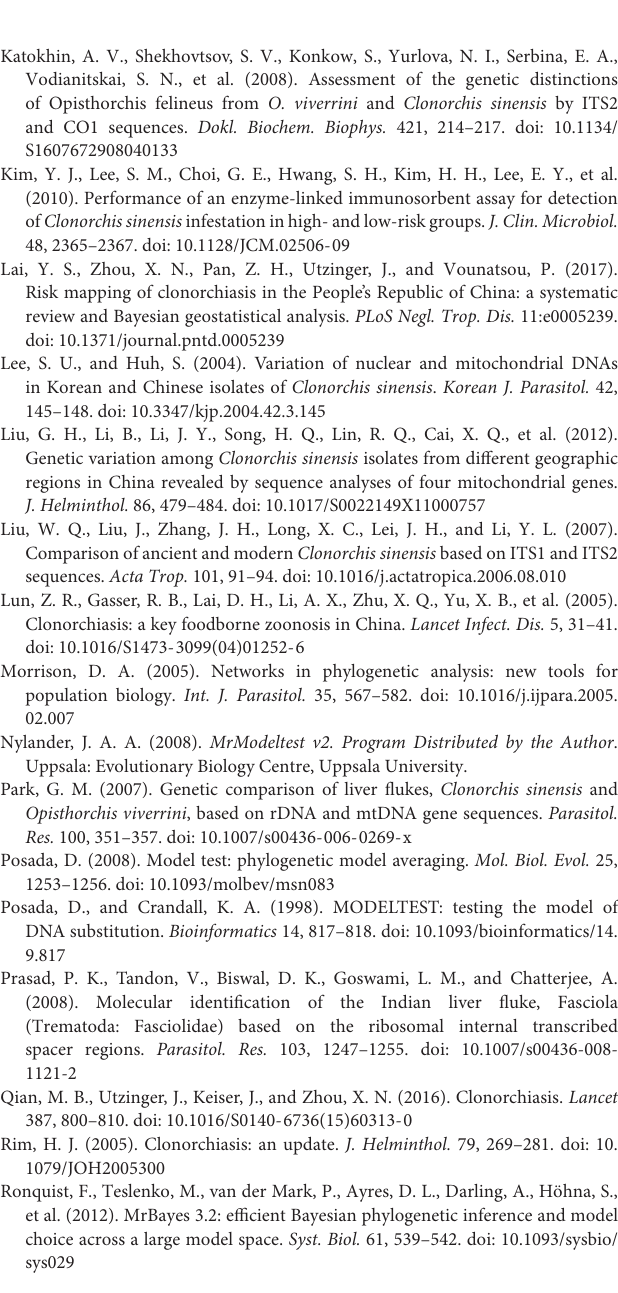
FIGURE S1 | The phylogenetic split network of the Clonorchis sinensis isolates based on the partial ITS1 rDNA sequences. Genotypes with black triangle are genotypes identified in this study, respectively. FIGURE S2 | The phylogenetic split network of the Clonorchis sinensis isolates based on the partial ITS2 rDNA sequences. Genotypes with black triangle are genotypes identified in this study, respectively. TABLE S1 | ITS1 sequences of C. sinensis worldwide. TABLE S2 | ITS1 sequences of C. sinensis by geographical location in China. TABLE S3 | ITS2 sequences of C. sinensis worldwide. TABLE S4 | ITS2 sequences of C. sinensis by geographical location in